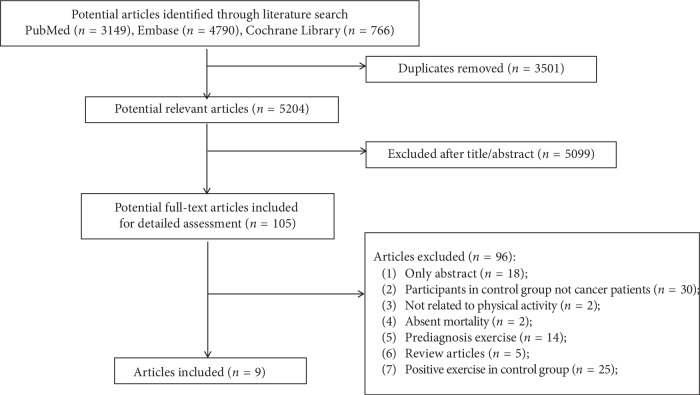
Flow diagram of study selection.